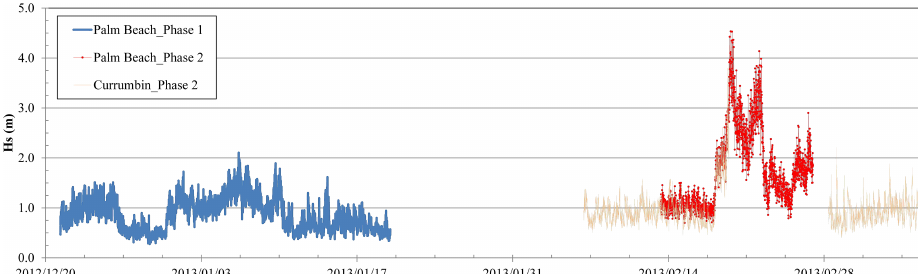
Fig. 3. Significant wave height at the nearshore wave recording